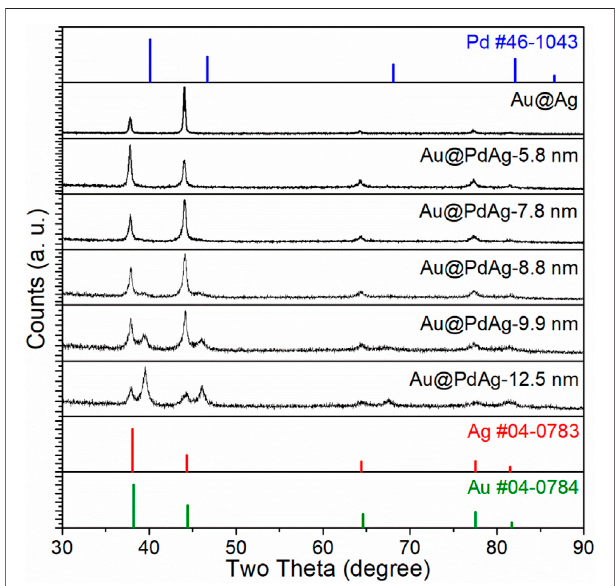
FIGURE 4 | XRD patterns of Au@PdAg core-shell concave nanocubes with different thickness of PdAg shell. Data of Au@Ag core-shell nanocubes and fcc- Pd/Ag/Au in JCPDS databased are provided for